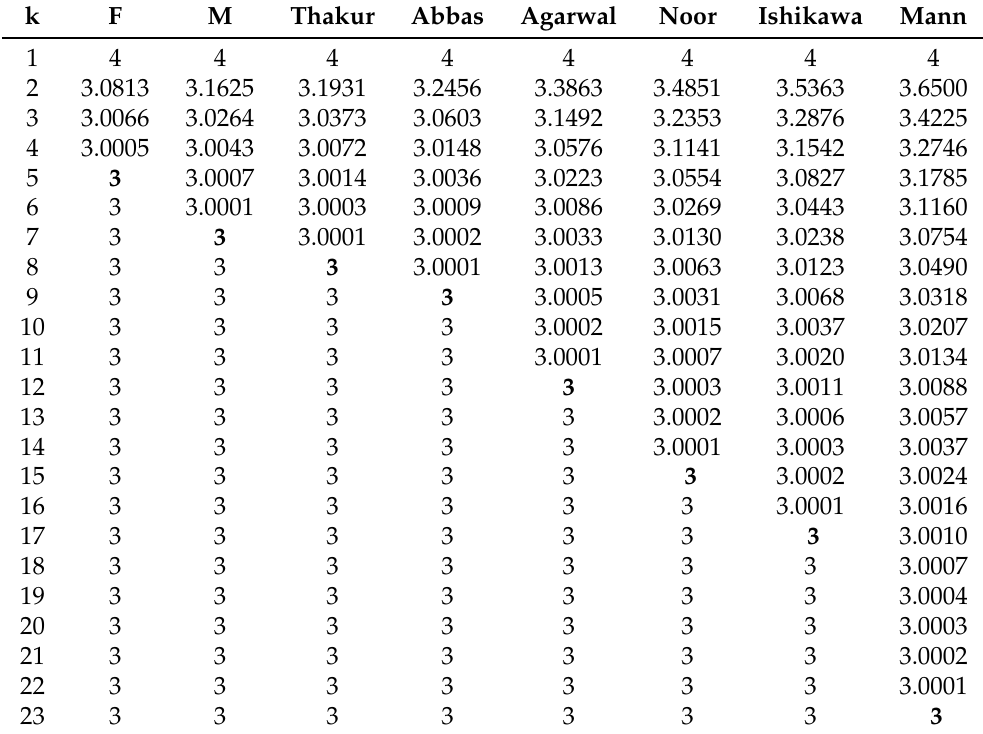
Table 1. Some values generated by F , M , Thakur, Abbas, S, Noor, Ishikawa and Mann iterations for the mapping T of Example 1.